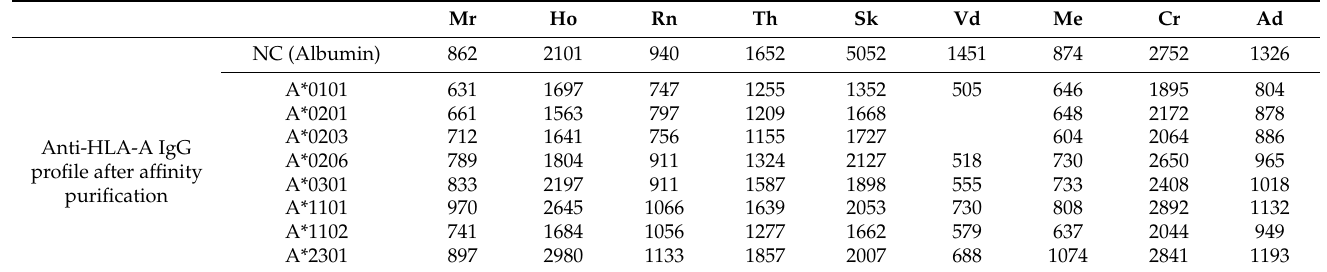
Table 5. HLA-Ia Ab profiles in the sera of normal non-alloimmunized male volunteers after purifi- cation of IgG using Protein-G affinity purification columns, elaborate the profile of the naturally occurring anti-HLA-I antibodies, suggesting that under natural conditions these antibodies may be masked by other factors, such as anti-idiotypic antibodies and immune